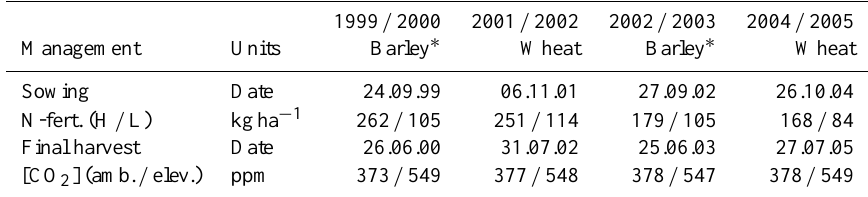
Table 2. Description of the experiments carried at the Braunschweig research station in Germany and how it was modelled in LPJ-GUESS. For a more detailed description of the experiments see Table 1 in Weigel and Manderscheid